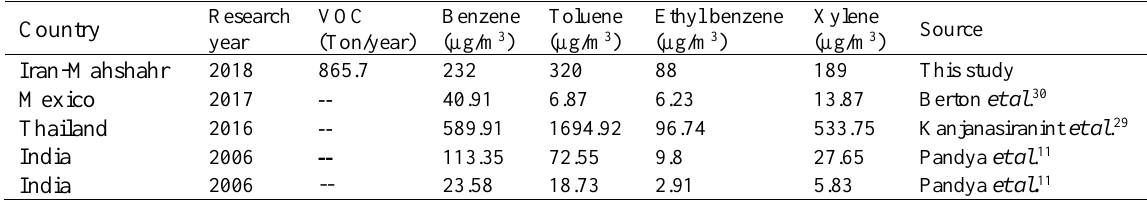
Table 5. Comparison of results with similar foreign studies Country